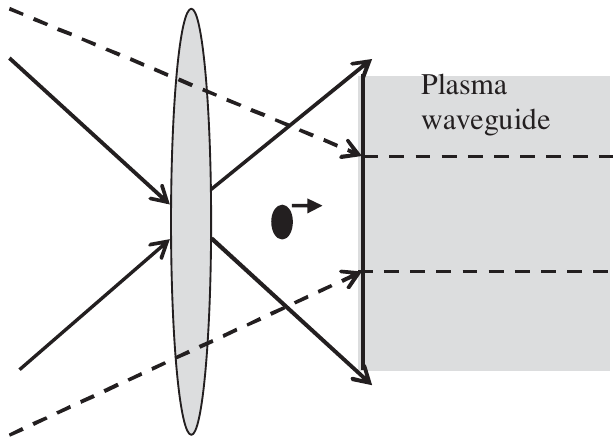
FIG. 11. Scheme of a two-stage laser wakefield accelerator with a short distance between the stages. A first laser pulse (depicted by the solid arrows) is tightly focused to a gas jet ( gray ellipse) and produces a relativistic femtosecond electron bunch (black ellipse) in the bubble regime. The bunch is injected into a channel-guided laser wakefield driven by a second broader laser pulse (depicted by dashed arrows) and then further accelerated in the channel to ultrarelativistic